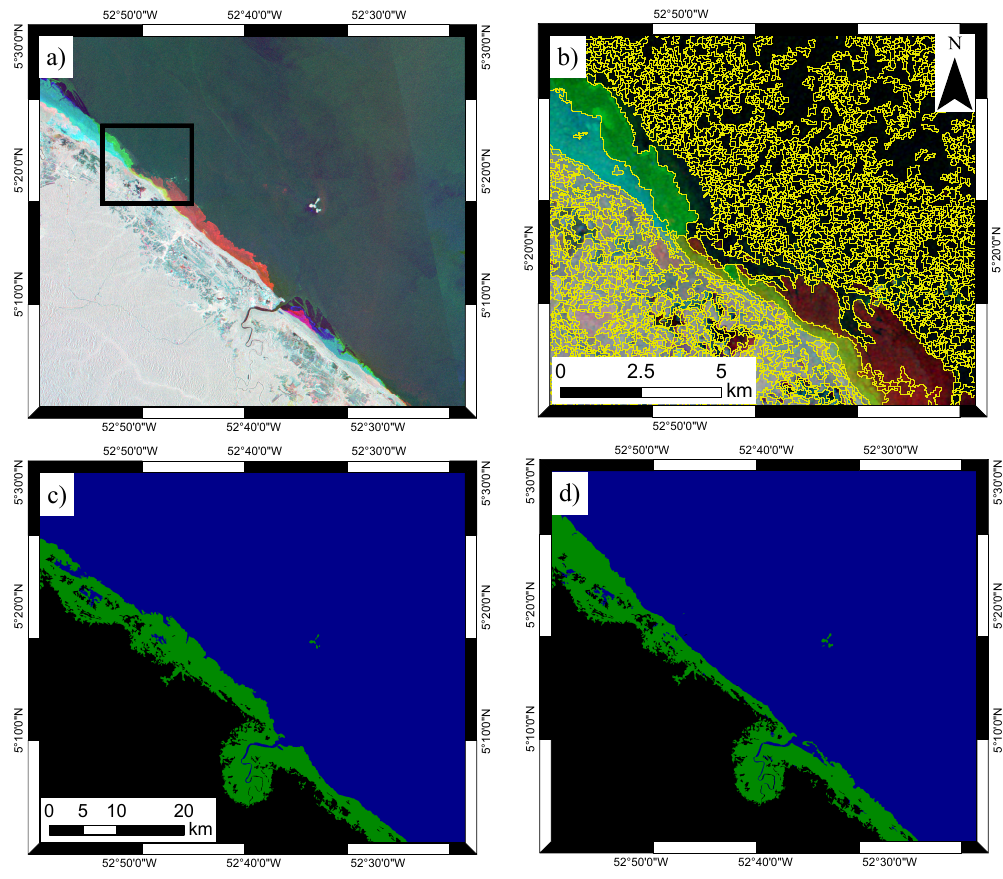
Figure 5. Classification of mangroves change using Japanese Earth Resources Satellite (JERS-1) and the Advanced Land Orbiting Satellite (ALOS) Phased-Array L-band SAR (PALSAR) data: ( a ) color composite of JERS-1 data from 1996 (red) and PALSAR data from 2007 (green) and 2010 (blue); ( b ) subset of scene showing segmentation; ( c ) classification of mangroves (green) using 1996 data; ( d ) updated classification of mangroves using 2010